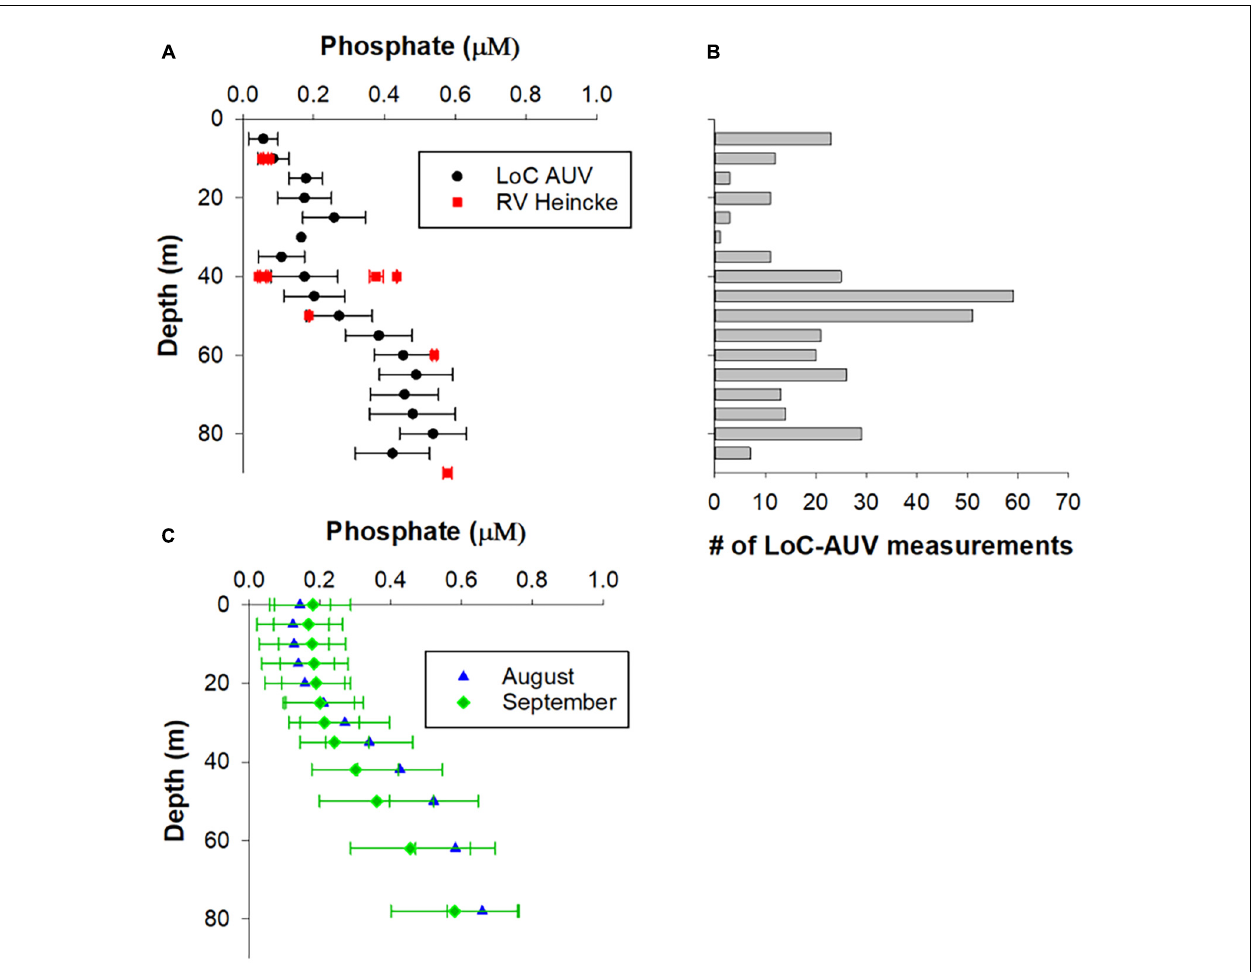
FIGURE 6 | Validation of phosphate LoC–AUV results. (A) LoC–AUV are binned into 5 depth bins and presented as arithmetic mean ± 1 SD. The data from RV Heincke were collected at four locations at the northern end of our transect (see Figure 2 for locations). (B) The number of LoC–AUV measurements within each depth bin. (C) Arithmetic mean ± 1 SD of phosphate concentrations for August and September from the North Sea Biogeochemical